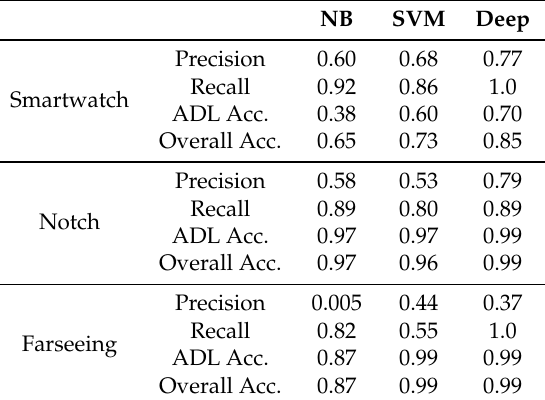
Table 2. Offline results by algorithm on 3